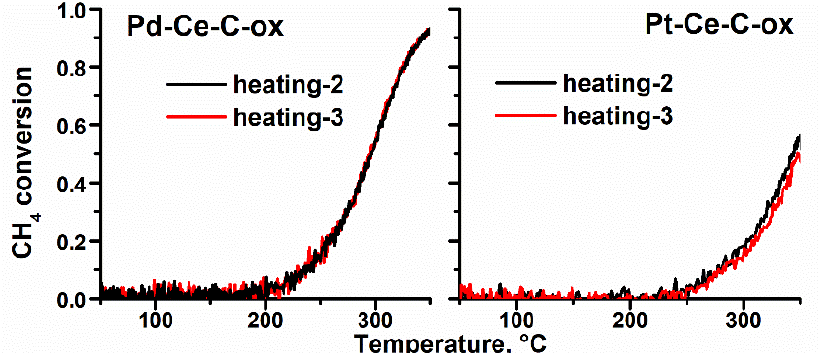
Figure A5. The temperature dependences of CH 4 conversion during the second and third heating runs of the samples in the reaction mixture in the TPR-CH 4 +O 2 mode for Pd-Ce-C-ox and Pt-Ce-C-ox catalysts.